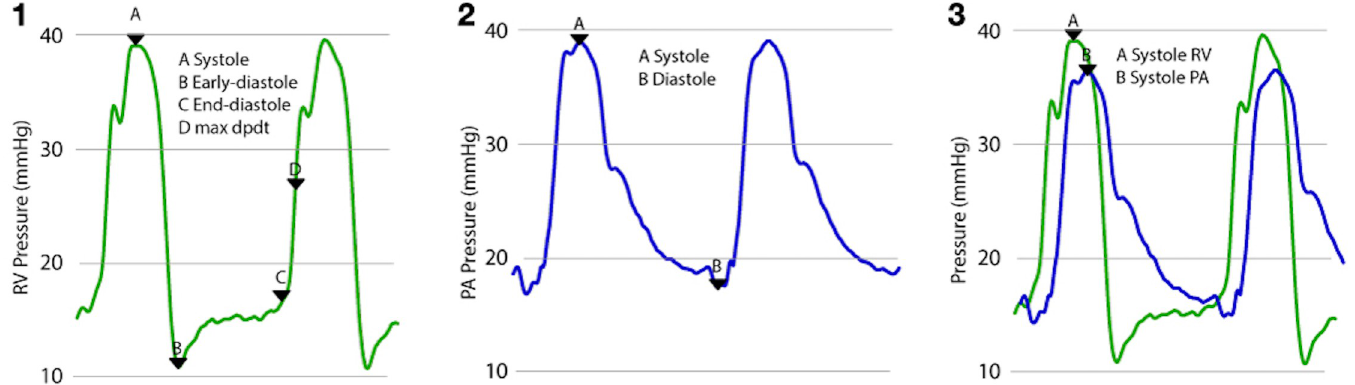
Fig 2. Schematic representation of right ventricular pressure ( ⎼⎼⎼ ) and pulmonary artery pressure ( ⎼⎼⎼ ) waveforms showing (1) the derivation of the right ventricular metrics of RV systolic pressure, RV early diastolic pressure, RV end diastolic pressure and the point of maximum dP/dt; (2) the derivation of the pulmonary artery metrics of PA systolic and PA end diastolic pressures; and (3) the overlapped waveforms showing peak RV and PA systolic pressures. The difference between these two pressures forms the RVOT gradient. Acronyms: max dP/dt, maximum rate of change in pressure over change in time; PA, pulmonary artery RV, right ventricular; RVOT, right ventricular outflow